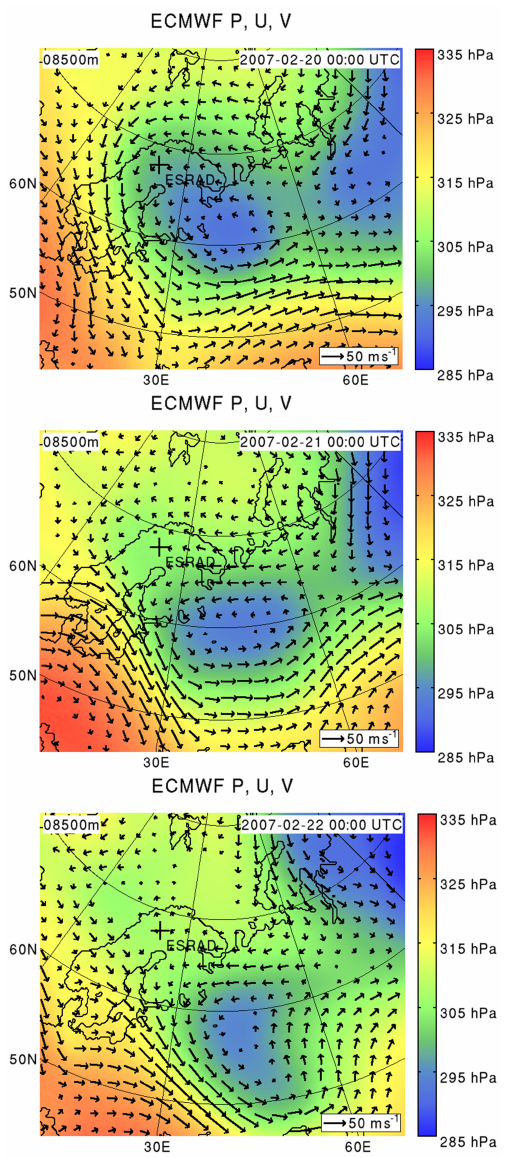
Figure 3. Horizontal cross sections at 8.5km altitude of pressure (colour) in hectopascal and horizontal winds (arrows) in metres per second, from top to bottom, at 00:00UTC on 20, 21 and 22 February 2007, from ECMWF analyses. The pressure scale is given by the coloured bar to the right, and the wind scale by the arrow at the bottom right corner of each panel. The black cross gives the location of ESRAD